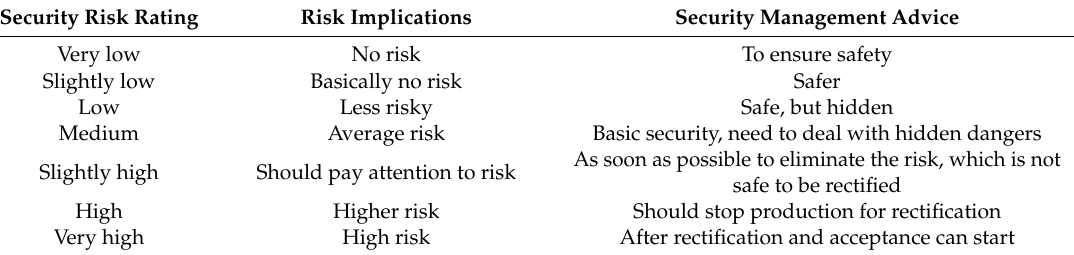
Table 4. Security risk rating evaluation